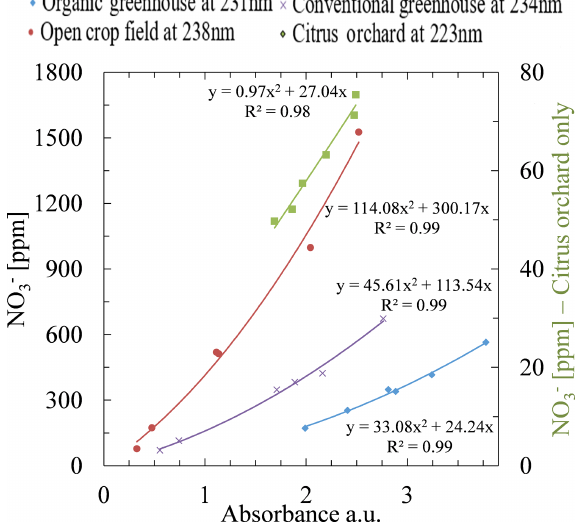
Figure 8. Calibration equations for the four study sites. As can be seen on the chart legend, each of the sites has its own unique optimal wavelength for estimating nitrate concentration. Note that the right ordinate shows a lower concentration range than the left ordinate and is associated only with the citrus